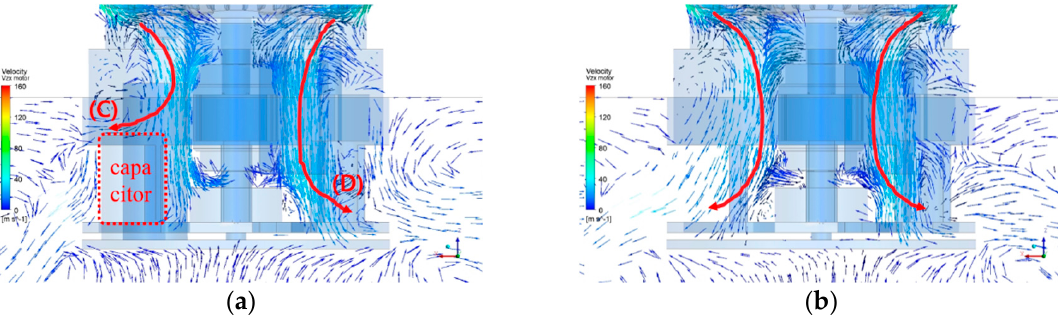
Figure 14. Computational fluid dynamic results of plane of x-z: ( a ) with capacitors; ( b ) without capacitors. Table 3. Estimation of efficiency in airflow with and without capacitors.